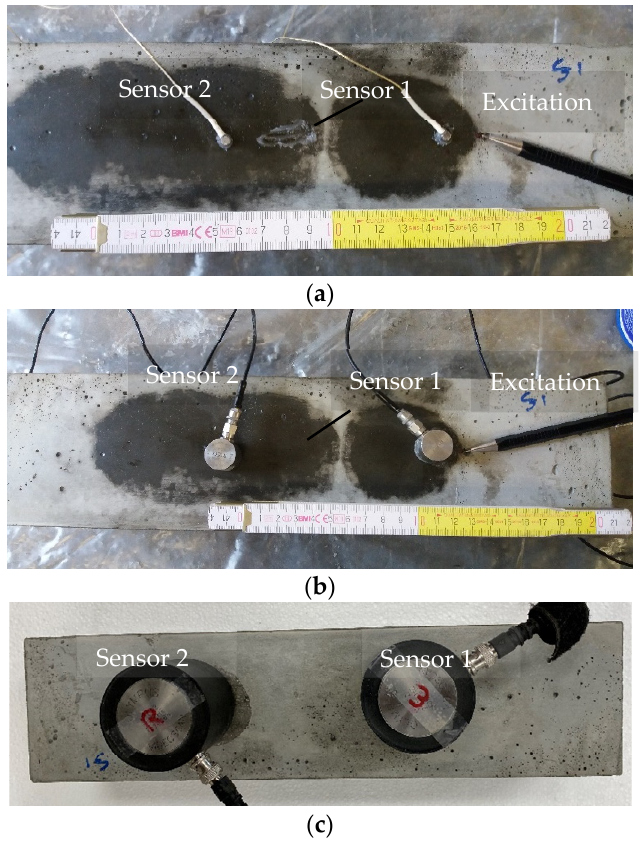
Figure 9. Photographs of surface wave measurements on concrete using different sensors: ( a ) Mistras pico sensor with 4-mm size, ( b ) Mistras R15 with 17.35-mm size, and ( c ) Olympus videoscan with 41.5-mm size.